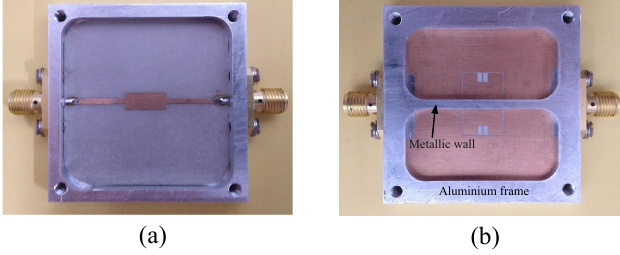
Figure 7. The fabricated sensor prototype ( a ) front view and ( b ) back view.